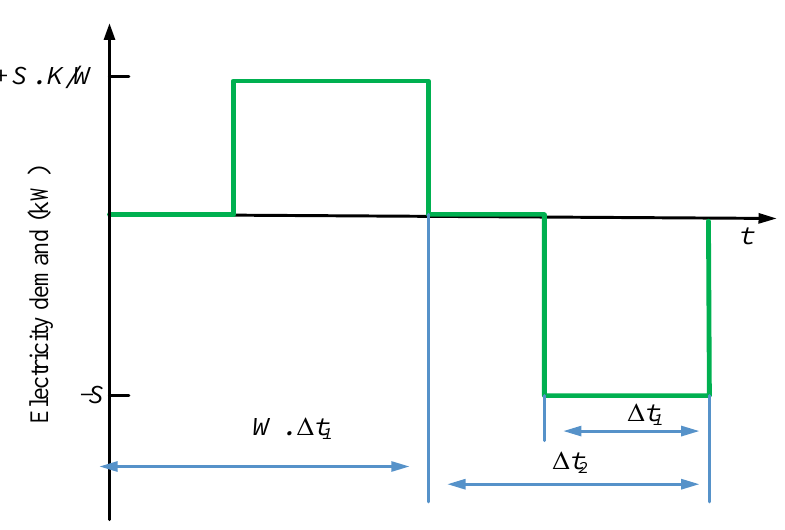
Figure 3. Illustration of a load shifting operation by a household appliance. S is the size of load reduction; K is the load recovery; W is the duration of K , greater or smaller than K ; t :